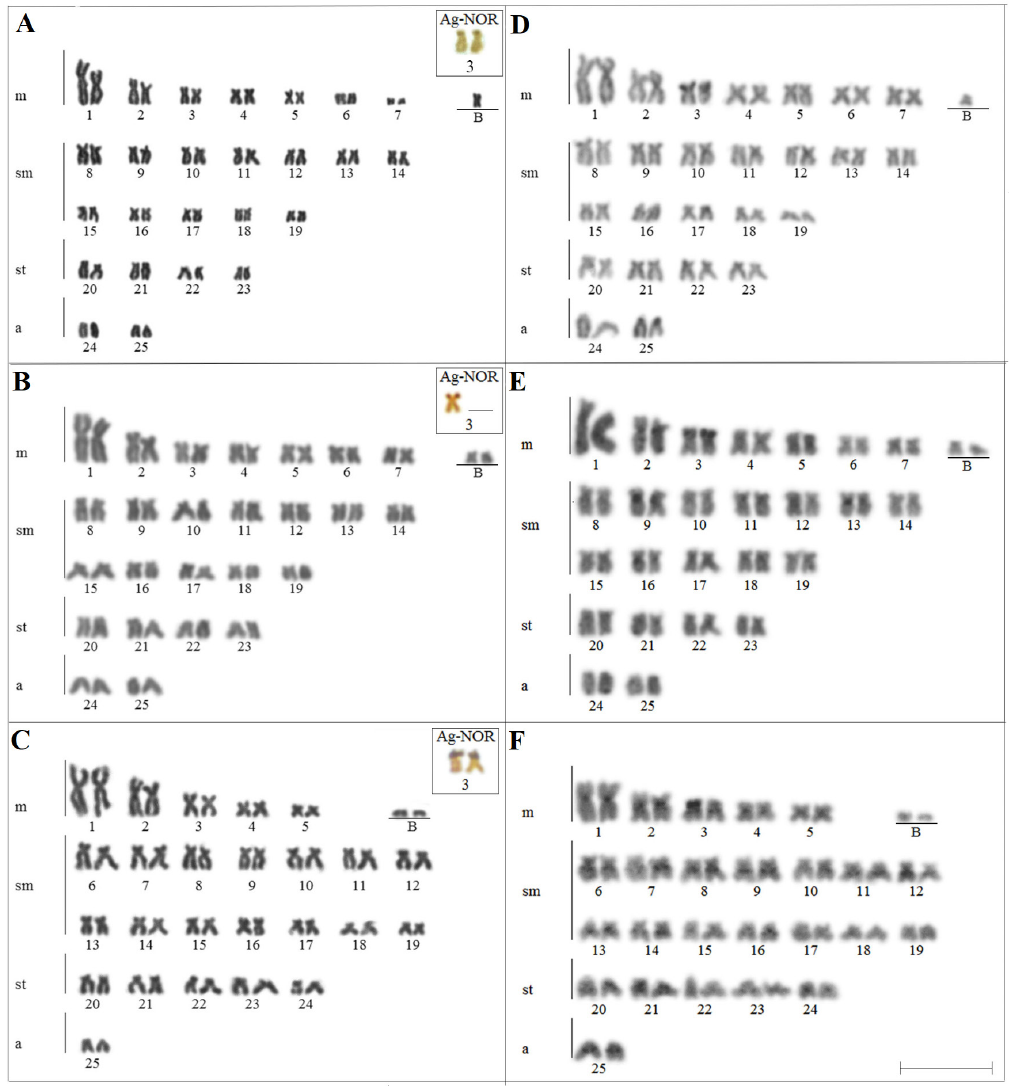
FIGURE 1 | Karyotypes A and D Moenkhausia bonita from the Índios River, B and E M. bonita from the Paraná River, C and F M. forestii from the Paraná River. Karyotypes A , B , and C stained with Giemsa, D , E , and F C-banded. In evidence the AgNOR-bearing chromosomes (box) and B chromosomes. Scales bar = 10